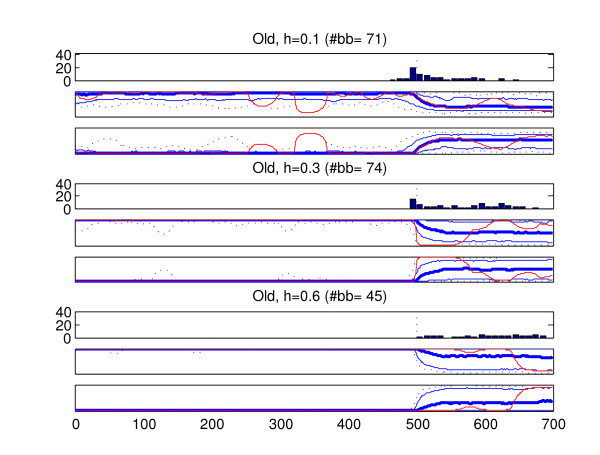
Results, old recombination event affecting all strains in a population. Summary of results for 200 strains belonging to a population whose all members have a recombined fragment from another population. Sites 501–700 have been obtained through recombination. See Figure 6 for the interpretation of the figure. Because the two populations now share the same fragment, the sites 501–700 could be assigned to either one of the possible populations. For this reason, also the probabilities assigned to the other possible right-side origin are shown (the third plot for each tree height), similarly to the probabilities assigned to the left-side origin (the second plot). In this case the 'correct' marginal probability profile would assign probability unity for the left-side origin in sites 1–500 and probability 0.5 in sites 501–700. The alternative right-side origin would be assigned in the 'correct' marginal probability profile probability zero in sites 1–500, and also probability 0.5 in sites 501–700. Similarly, the 'correct' optimal model profile would assign the sites 501–700 to either of the two populations. Notice that the y-scale of the histogram plots is different from other result Figures (6, 7, 9 and 10).